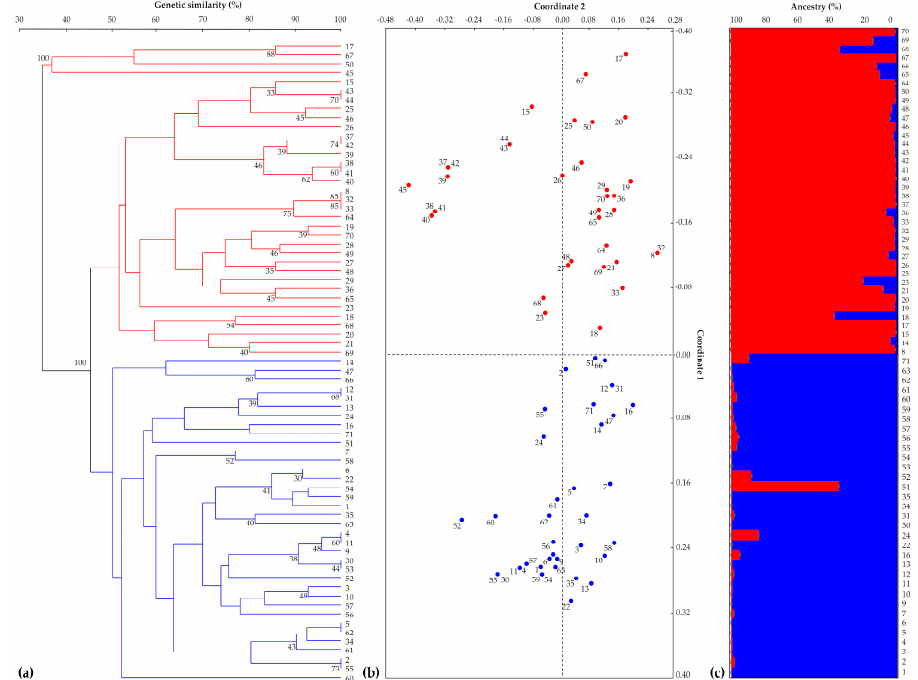
Figure 2. ( a ) Genetic similarity-based unweighted pair group method with an arithmetic mean (UPGMA) dendrogram of 71 parental lines calculated using the Jaccard coe ffi cient. Bootstrap estimates ≥ 30% are reported next to the nodes (red and blue branches indicate the two clusters identified). ( b ) Principal coordinate analysis (PCoA). The 71 samples are shown in red or blue according to the clustering shown in the UPGMA tree. ( c ) The population genetic structure of the 71 lines as estimated by STRUCTURE. Each sample is represented by a vertical histogram partitioned into K = 2 coloured segments (red or blue, in accordance with ( a , b )) representing the estimated membership. The proportion of subgroup membership (%) is reported on the ordinate axis, and the identification number of each accession is reported below each